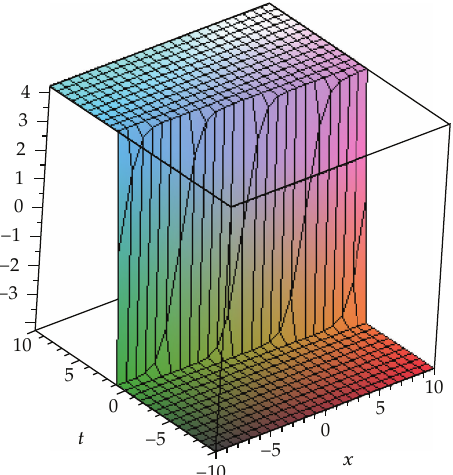
Figure 1: Periodic solution for α (cid:8) − 1, y (cid:8) 0 and z (cid:8)